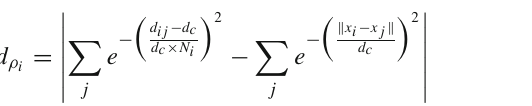
the local density. The equation of the relationship